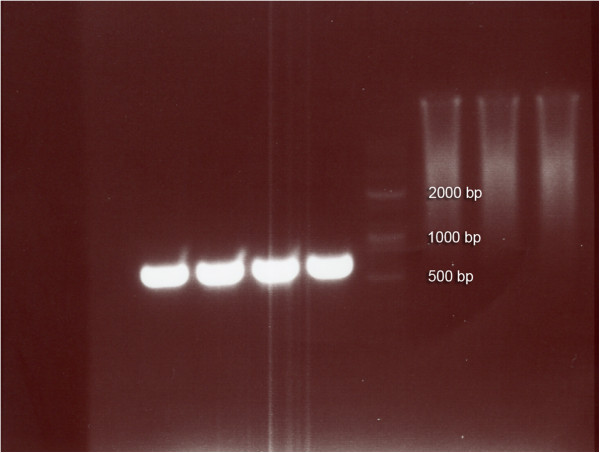
Agarose gel electrophoresis of
Legionella
s' amplified DNA extracted from different hospital water sources.